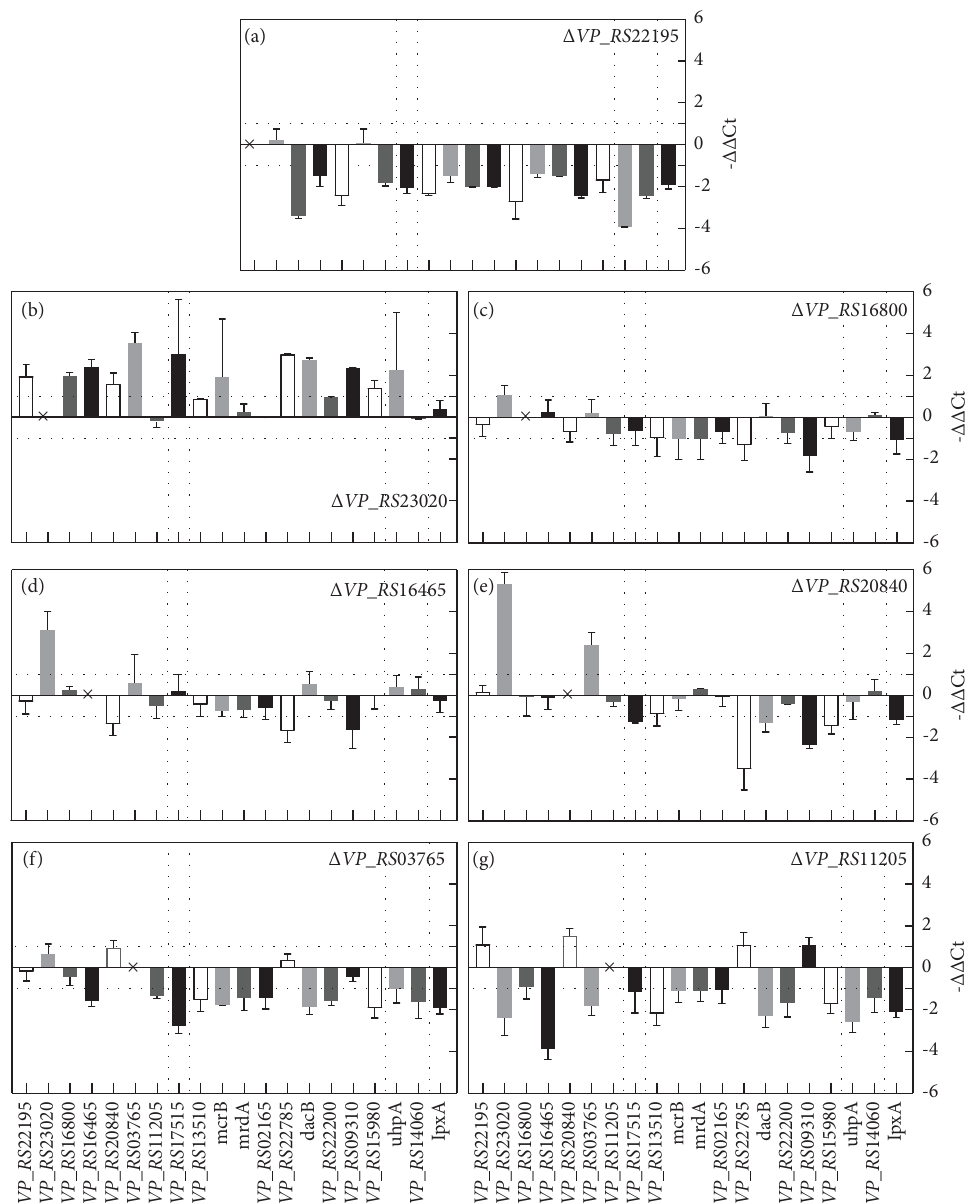
Figure 5: Comparison of transcription of 20 genes in the 7 V. parahaemolyticus OMP deletion mutants, using wild-type ATCC33846 as a control. Five kinds of genes are divided by dotted line: OMP genes, β -lactamase genes, PG synthesis-related genes, stress-regulation-related genes, and lipid A synthesis genes. VP_RS17515 expresses β -lactamase. Te transcription change fold is calculated by 2 − ΔΔ Ct . Each bar represents the mean value of three biological replicates, and error bars represent standard deviations calculated from three biological